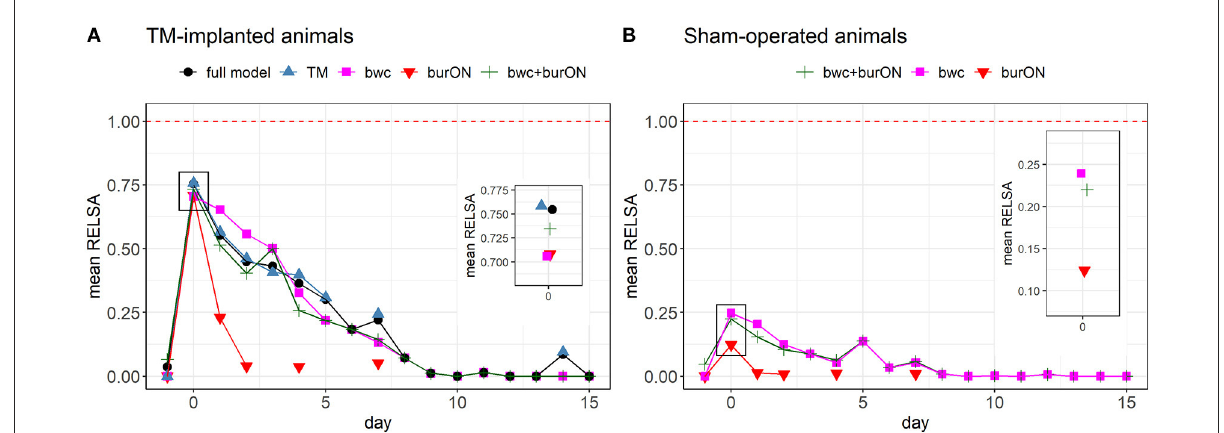
FIGURE4 (A) Comparison of RELSA performances using different input variables in the TM-implanted animals ( n = 13). The red dashed line (RELSA = 1) represents the maximum in the reference model. The full model comprised the outcome measures bwc, burON, hr, hrv, act, and temp. The inlay plot focuses on the RELSA values on day 0 (after surgery). Here, the average RELSA values are highest and close together RELSA mean,0 = 0.73 (SD = 0.02, range = [0.71; 0.76]) at a low error rate. The highest-performing models are the TM outcomes (hr, hrv, act, and temp, mean = 0.76), followed by the full model (mean = 0.75). During recovery, the performances vary due to changing contributions to the RELSA score. However, the models appear interchangeable as the RELSA weighs and regularizes missing information, especially in highly collinear data. (B) Comparison of RELSA performances using different input variables in the Sham-operated animals ( n = 15). The maximum RELSA is indicated by bwc (mean = 0.24). Note that burON alone has a lower RELSA value than bwc on day 0 (mean = 0.12). However, the combination of bwc and burON can capture most of the severity information on day 0 as indicated by bwc (see inlay plot). Consequently, the combination of bwc and burON (mean = 0.22) performs slightly lower than bwc alone. The burrowing behavior was not measured on all days, so the main RELSA information is dependent on bwc in these cases. The RELSA is relative invariant against missing input variables when multiple measures are included.